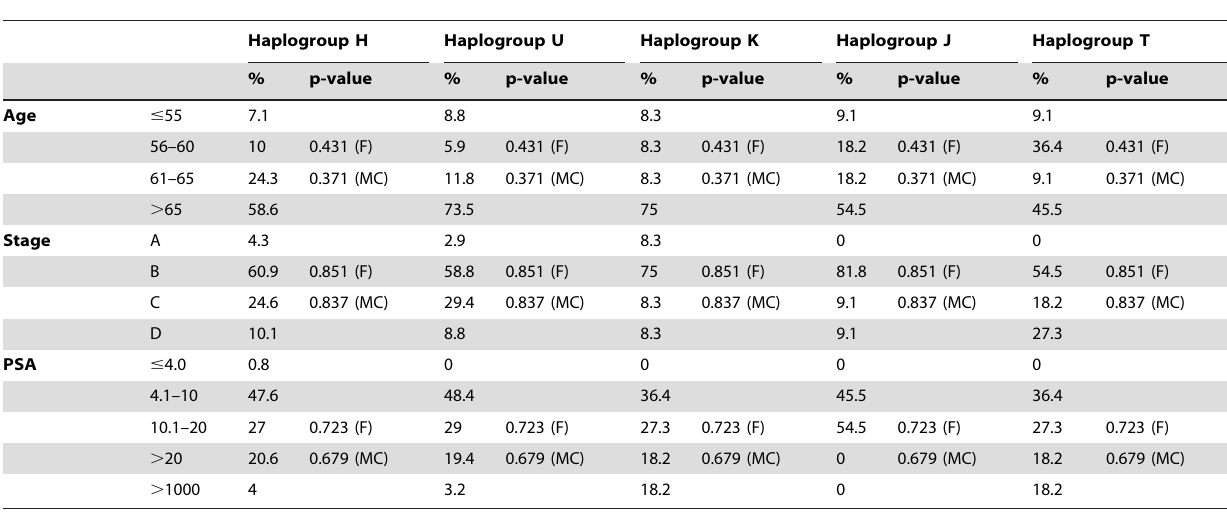
Table 4. Summary of statistical data on haplogroups in patients and clinical data.